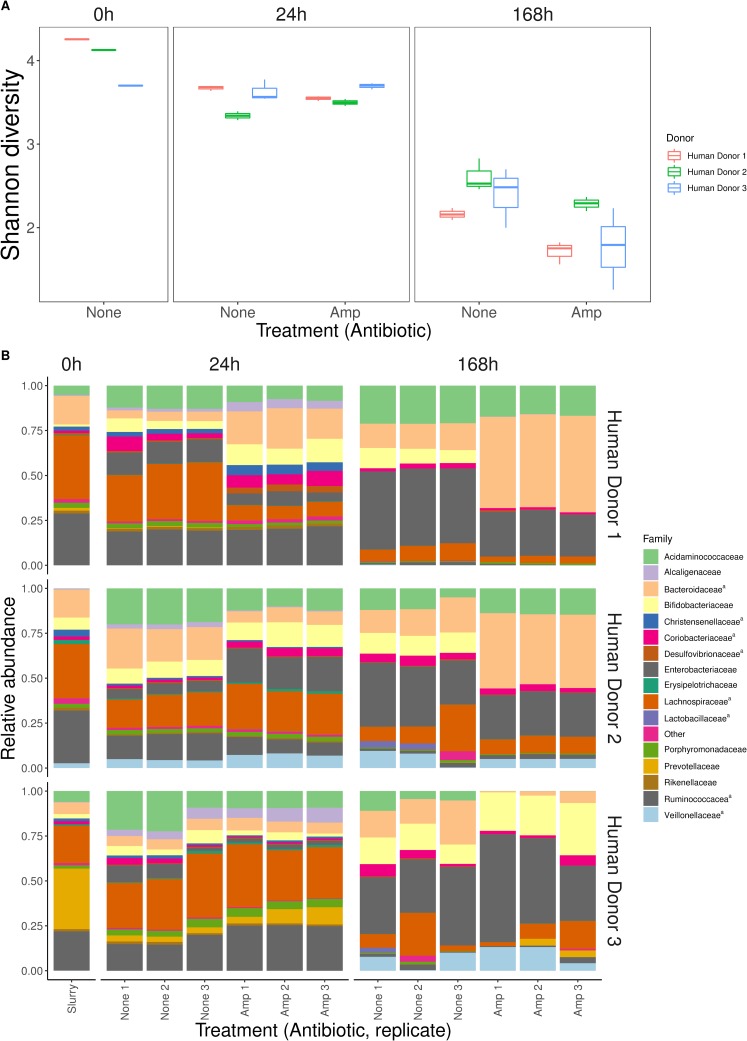
Within-sample diversity and changes in community composition over time.(A) Diversity is estimated here using Shannon's diversity index for samples from three time points (0 h, 24 h, and 168 h, shown at top) and three human donors (see legend), in the presence and absence of ampicillin (‘Amp’, x-axis). Each box shows data from three replicate microcosms per treatment group and time point (except for at 0 h, which shows the single initial sample from each human donor). (B) Relative abundance of the 15 most prevalent bacterial families in each microcosm at three time points (0 h, 24 h, and 168 h, shown at top) for each human donor (rows of panels, labelled at right) in the presence and absence of ampicillin (three replicates each treatment; x-axis). Superscript ‘a’ in the legend indicates obligately anaerobic families. Data are deposited in the European Nucleotide Archive under the study accession number PRJEB33429.